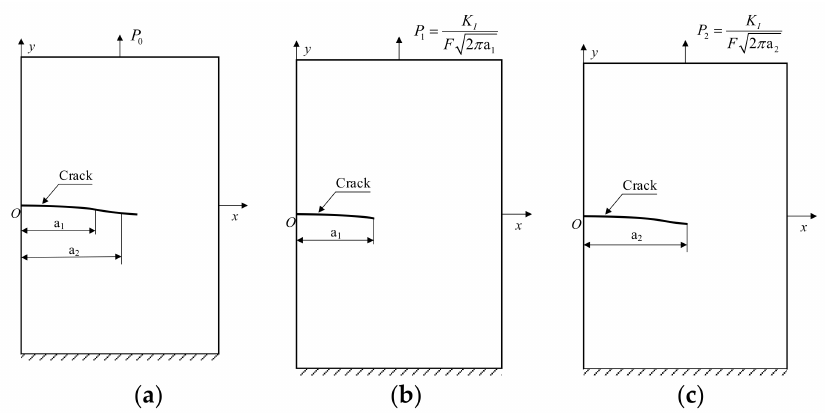
Figure 3. Relationship and analysis steps between ( a ) the XFEM model and ( b ) the static crack model I and ( c ) the static crack model